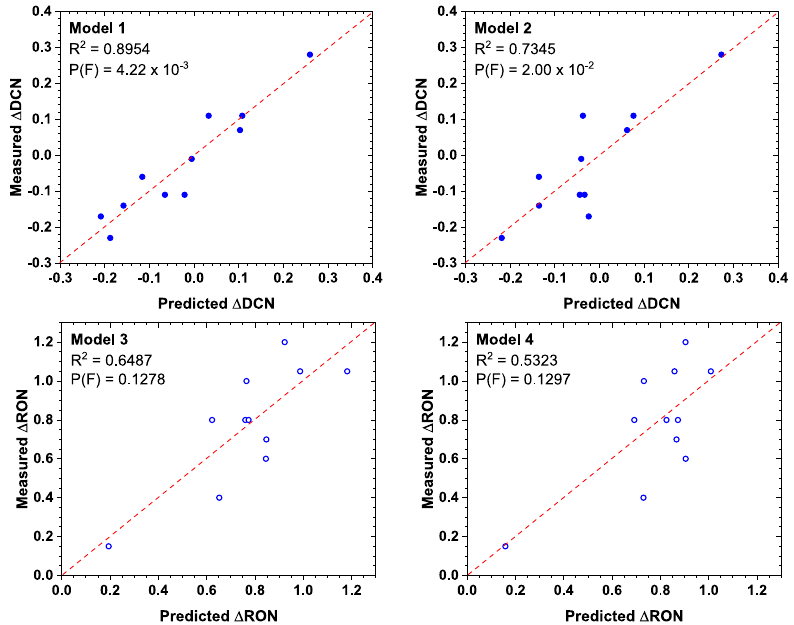
Figure 4. Predicted vs. measured DCN and RON for the models described in Tables 2 and